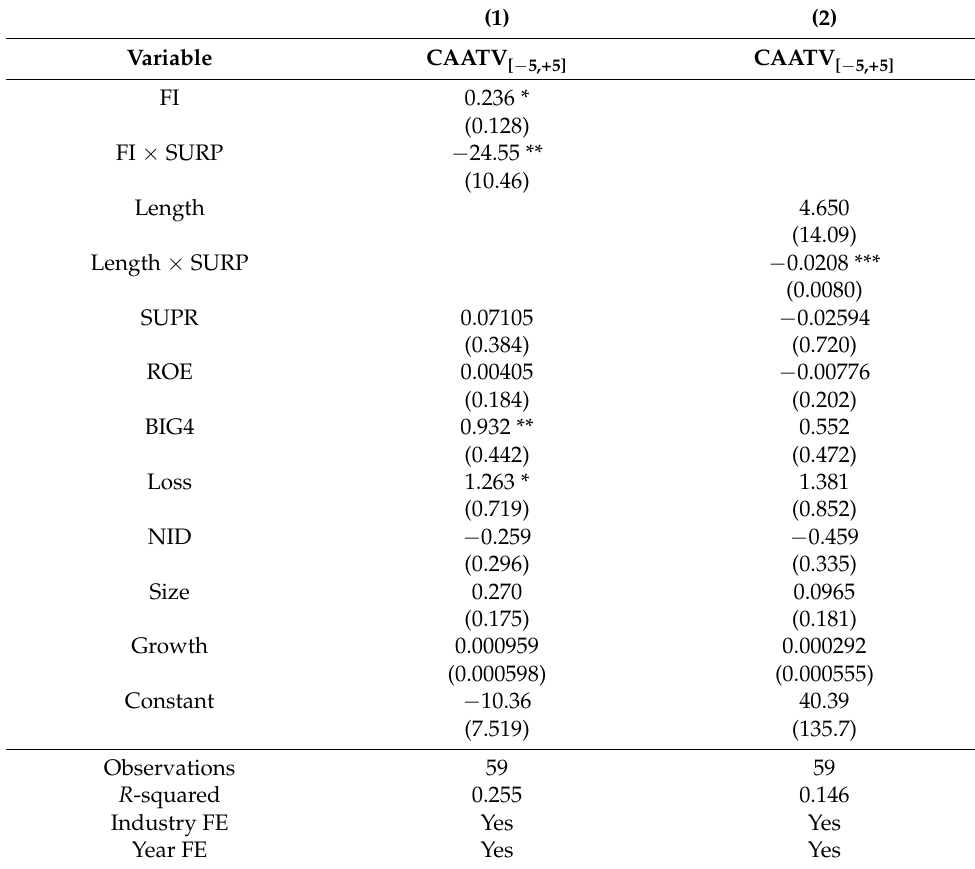
Table 5. Effect of readability on cumulative abnormal trade volume.